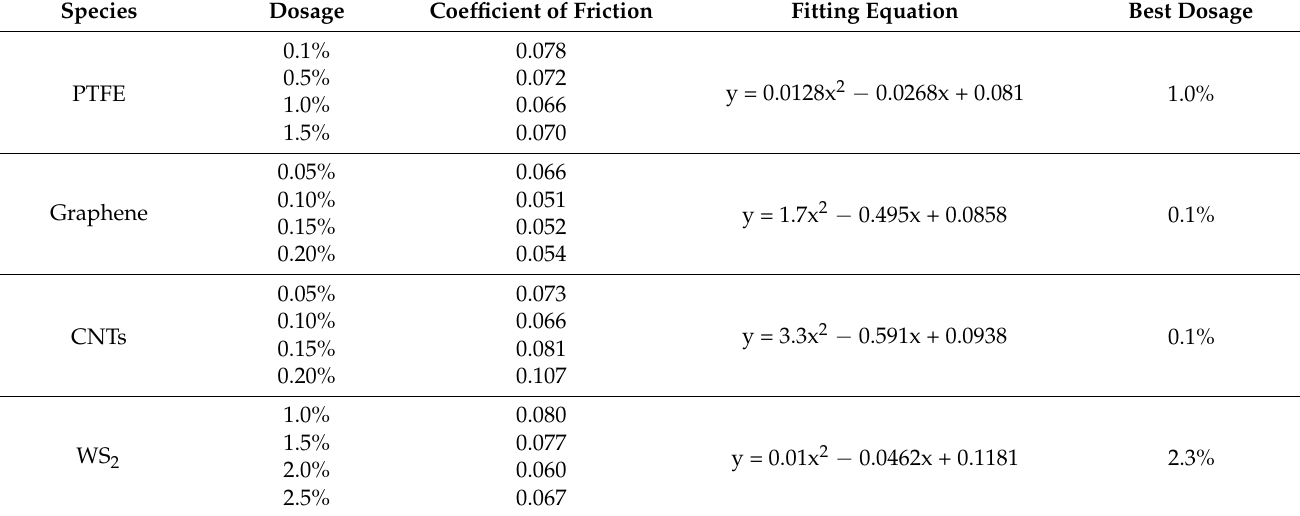
Table 4. Optimum dosage of spherical hinge grease